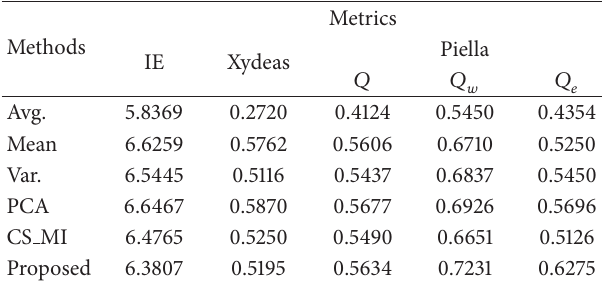
Table 1: The quantity assessment of fusion methods for CT and MRI